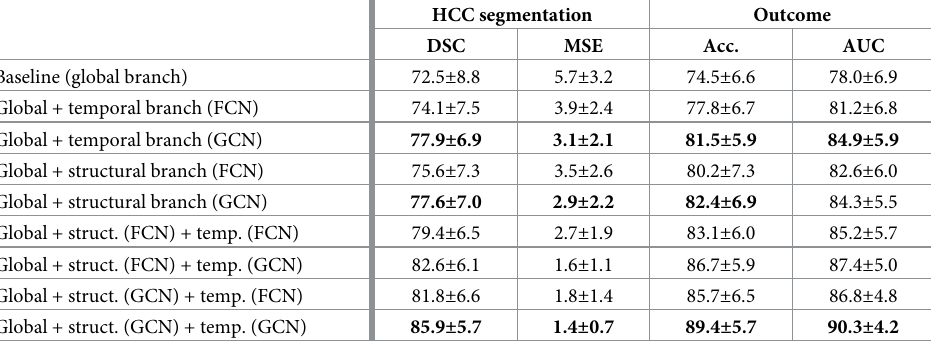
Table 1. Ablation experiments, comparing the addition of the structural and temporal branches to the proposed STDGNN. A comparison is also made between the fully convolutional network (FCN) and the graph convolutional network (GCN). DSC: Dice similarity in %, MSE: Mean squared error (mm), Acc: classification accuracy in %, AUC: area under curve (AUC). Analysis of differences was performed by paired Wilcoxon tests ( p < 0.05). Bold values indi- cate significant difference to baseline.